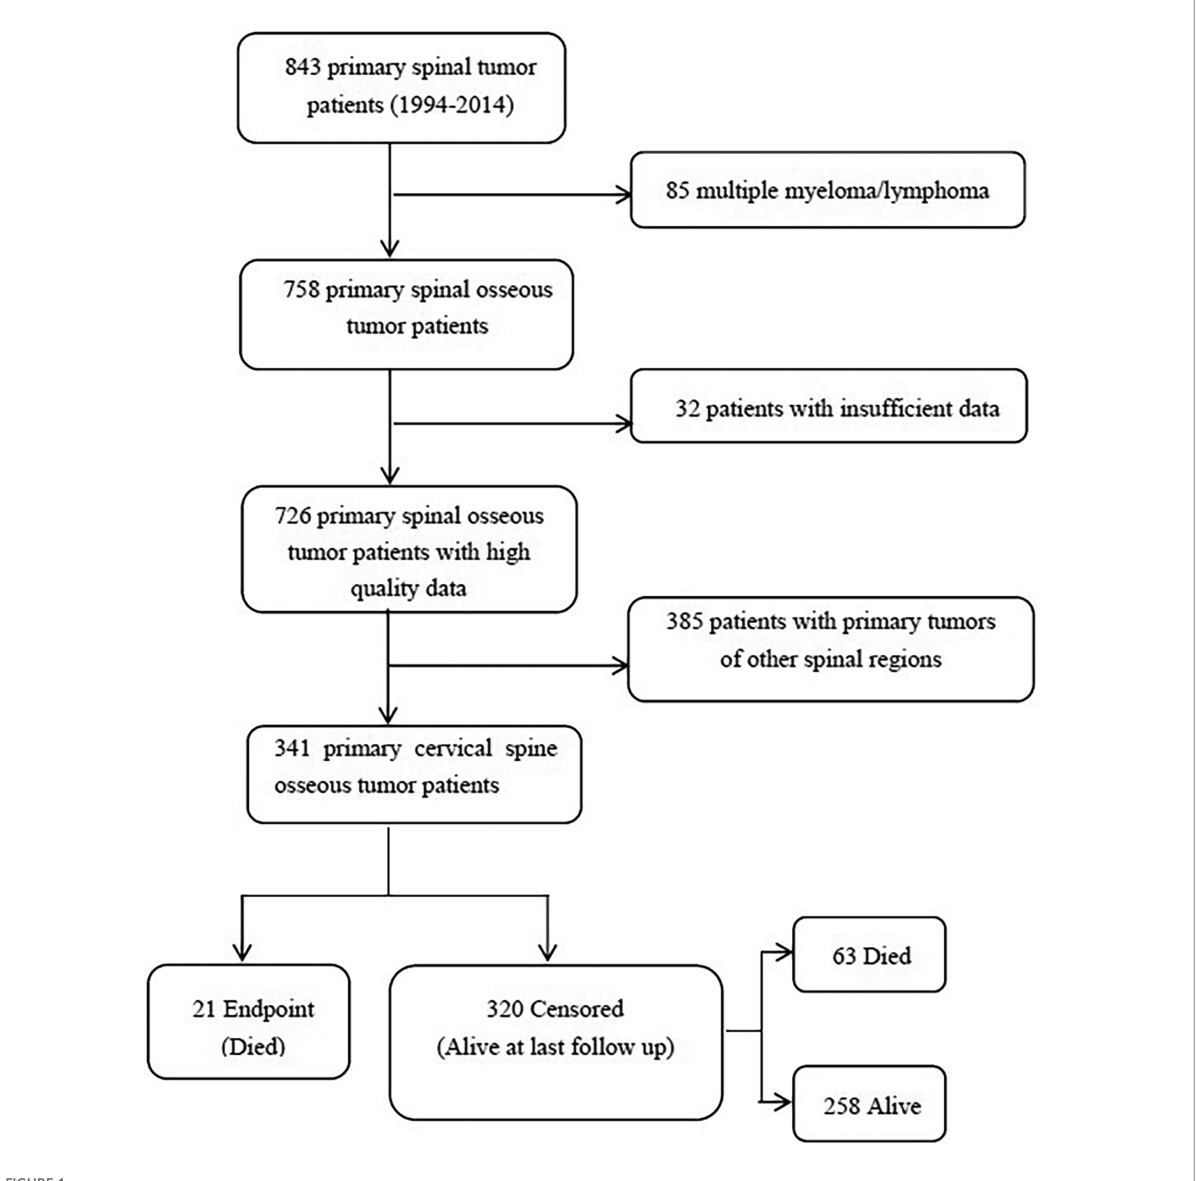
FIGURE 1 Screening process for the 341 patients with primary cervical spinal